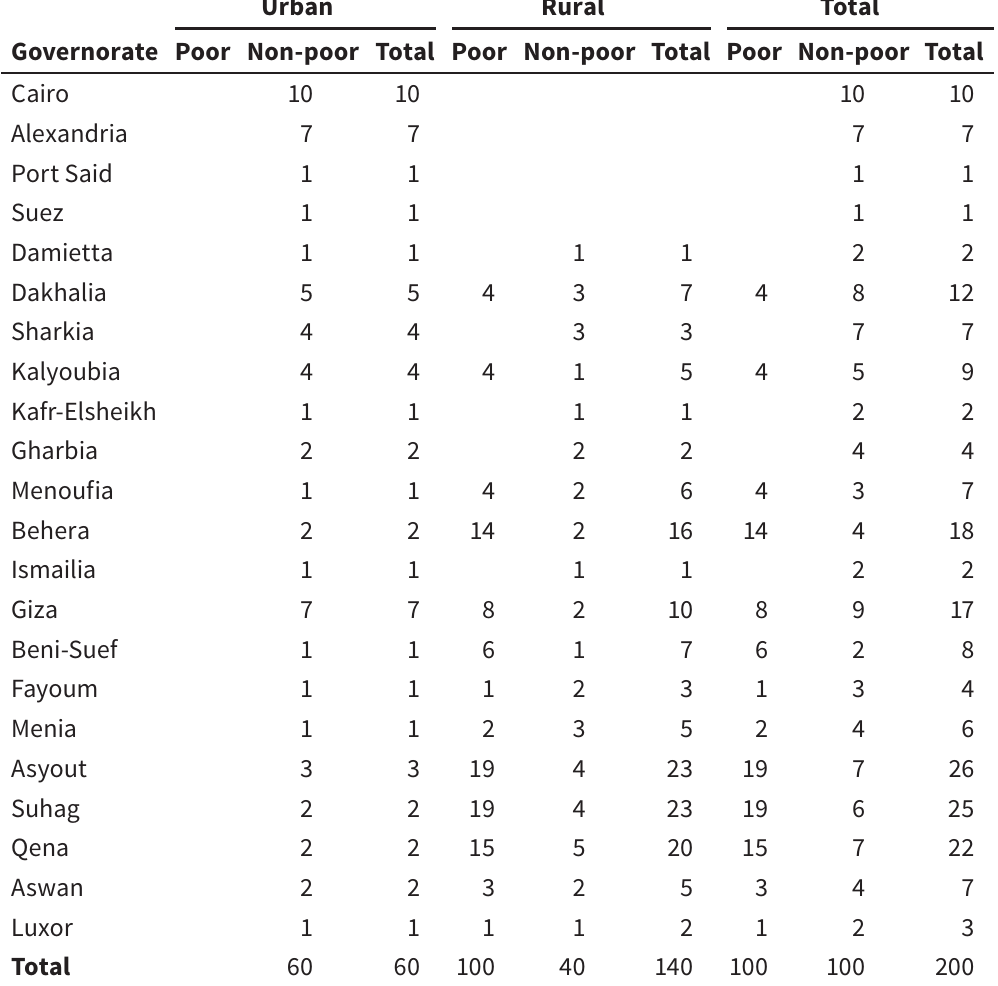
Refresher sample clusters by governorate, urban/rural location, and poor vs . non-poor Urban Rural